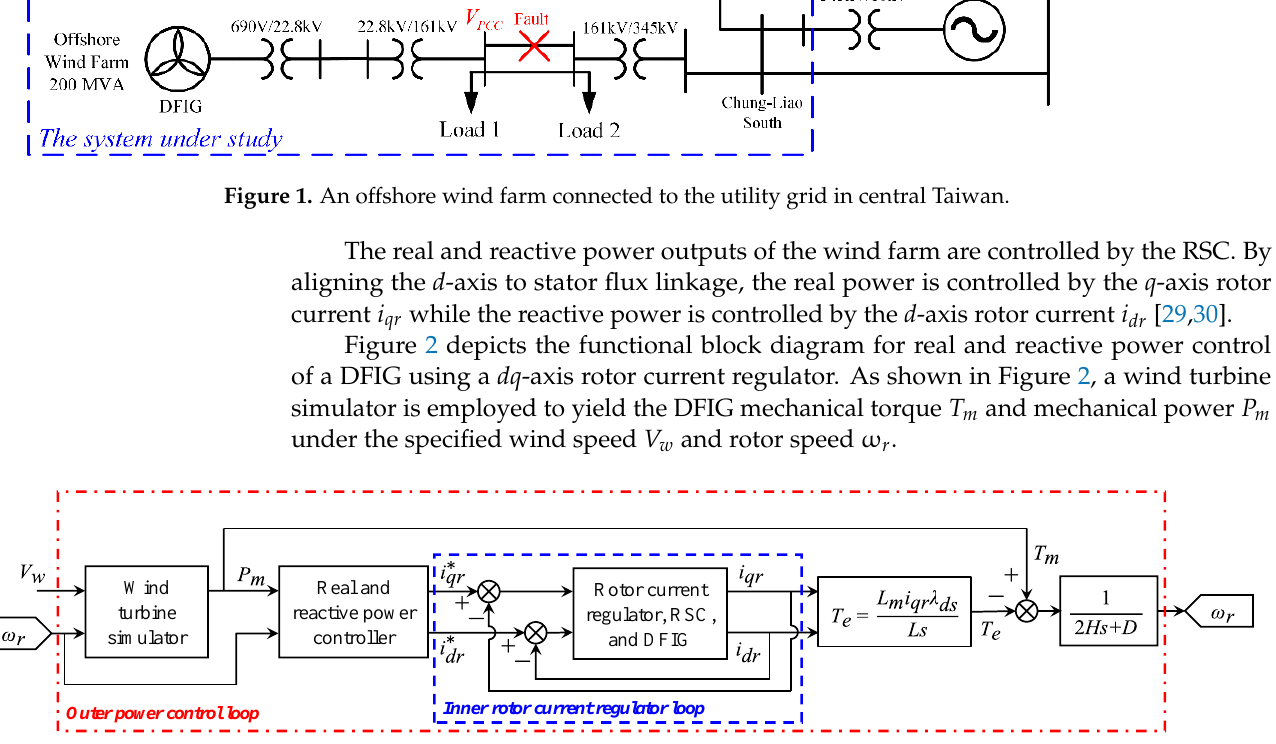
Figure 1. An offshore wind farm connected to the utility grid in central Taiwan.